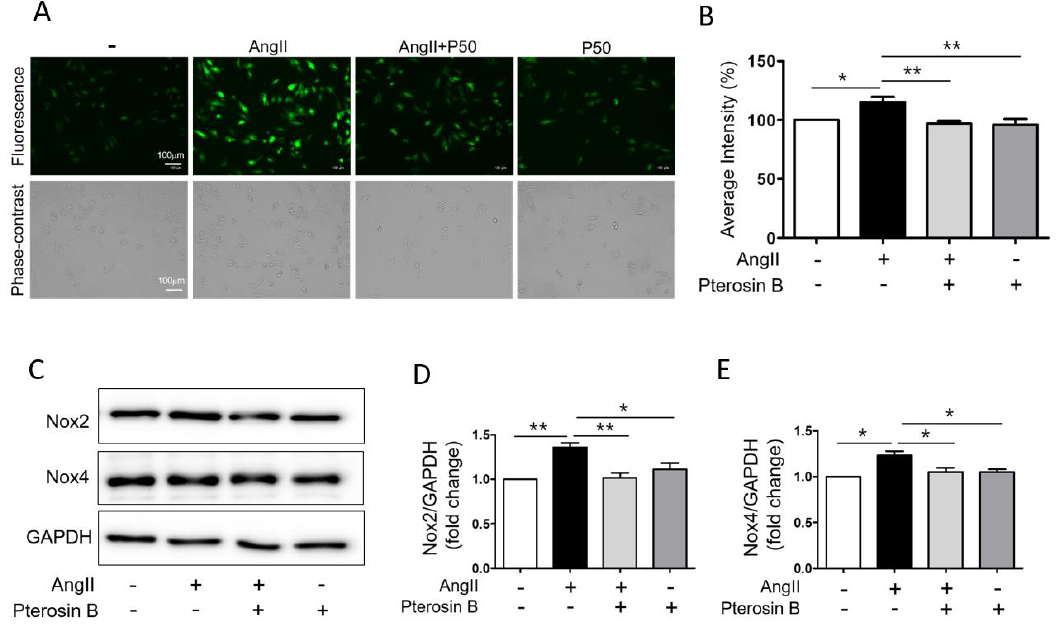
Figure 5. Anti-oxidant effect of Pterosin B in Ang II-treated H9c2 cells. ( A ) H9c2 cells were treated with 300 nM Ang II for 2 h with or without Pterosin B. The intracellular ROS levels were detected by CM-H 2 DCFDA (upper panel) and phase-contrast image was obtained to confirm cell morphology (lower panel). P50 = Pterosin B (50 μ M). Scale bar = 100 µm. ( B ) Quantification of the fluorescence intensity of H9c2 cells in each condition. n = 6. ( C ) H9c2 cells were treated with 300 nM Ang II with or without Pterosin B for 2 h and the protein expression of NOX2, NOX4, and GAPDH was examined by western blotting. ( D – E ) Quantification of protein levels shown in ( C ). The levels of protein were normalized to GAPDH expression. * p < 0.05, ** p < 0.01. n = 3.